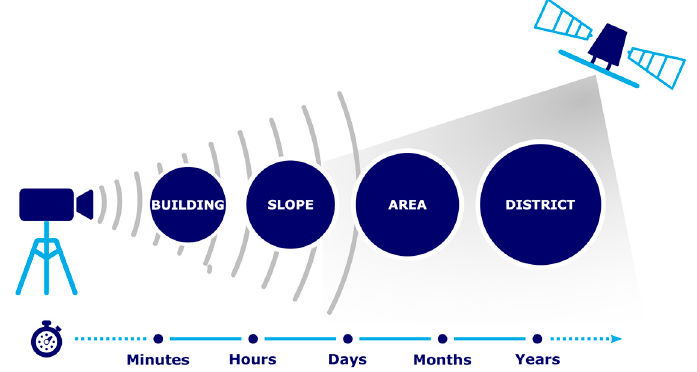
Figure 1. Complementarity of GBRI with spaceborne SAR.